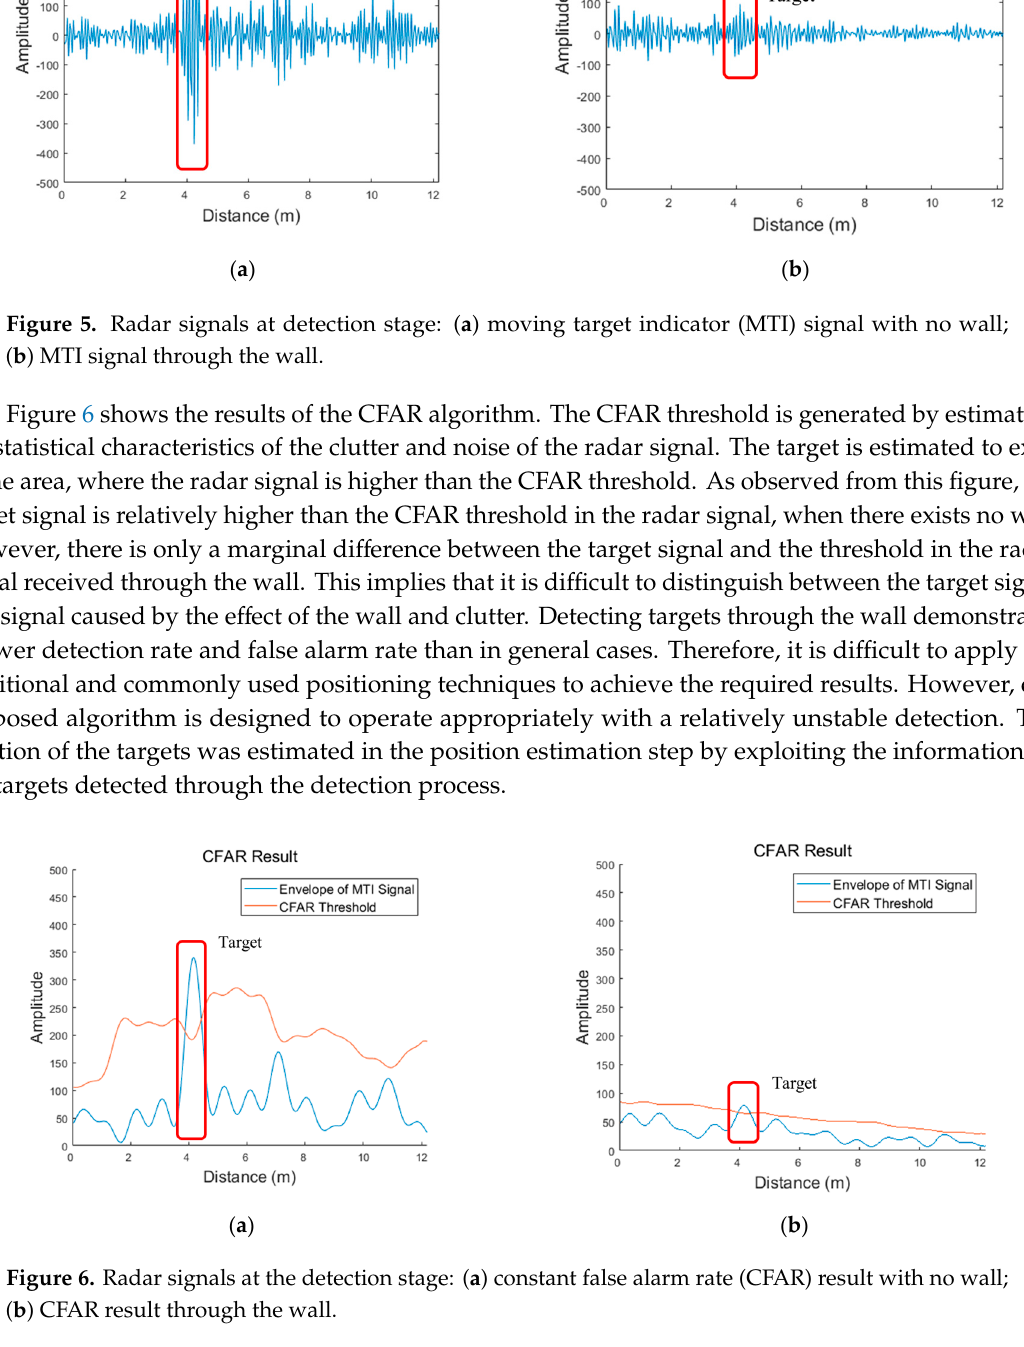
Figure 5. Radar signals at detection stage: ( a ) moving target indicator (MTI) signal with no wall; ( b ) MTI signal through the wall.